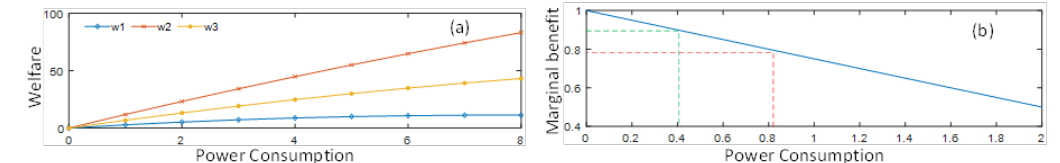
Figure 2. ( a ) Graphical representation of welfare functions; ( b ) marginal benefit for different power consumptions.